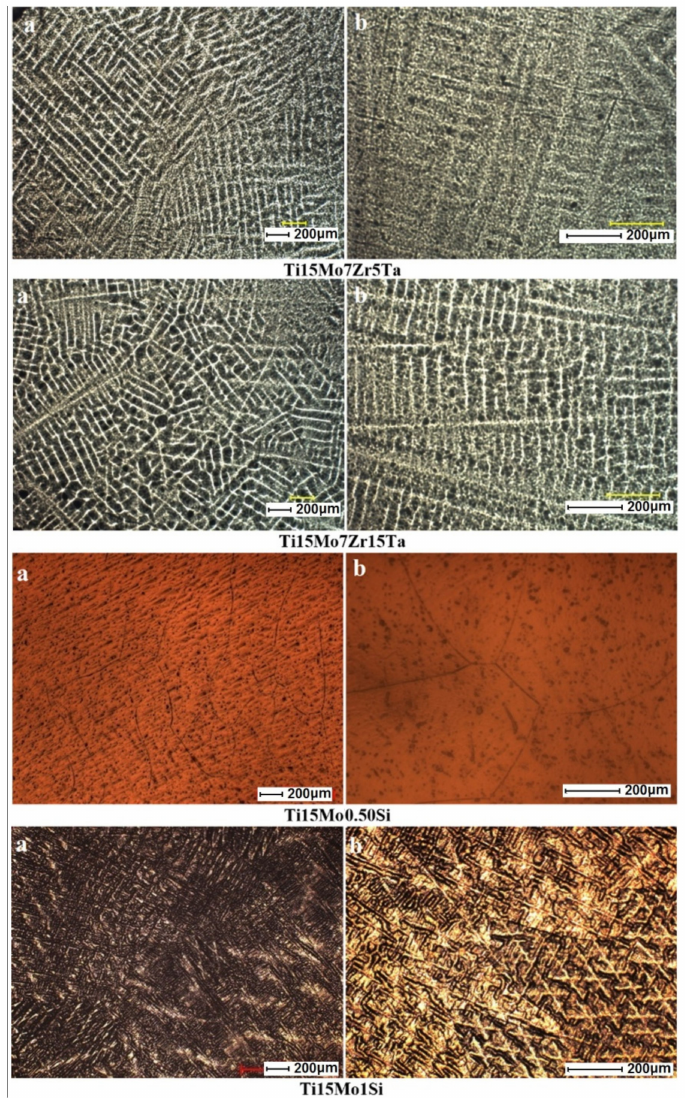
Figure 2. Optical microstructure images of titanium alloys Ti 15 Mo 7 Zr 5 Ta, Ti 15 Mo 7 Zr 15 Ta, Ti 15 Mo 0.5 Si, and Ti 15 Mo 1 Si at various magnifications: ( a ) 50 × , ( b ) 100 × .